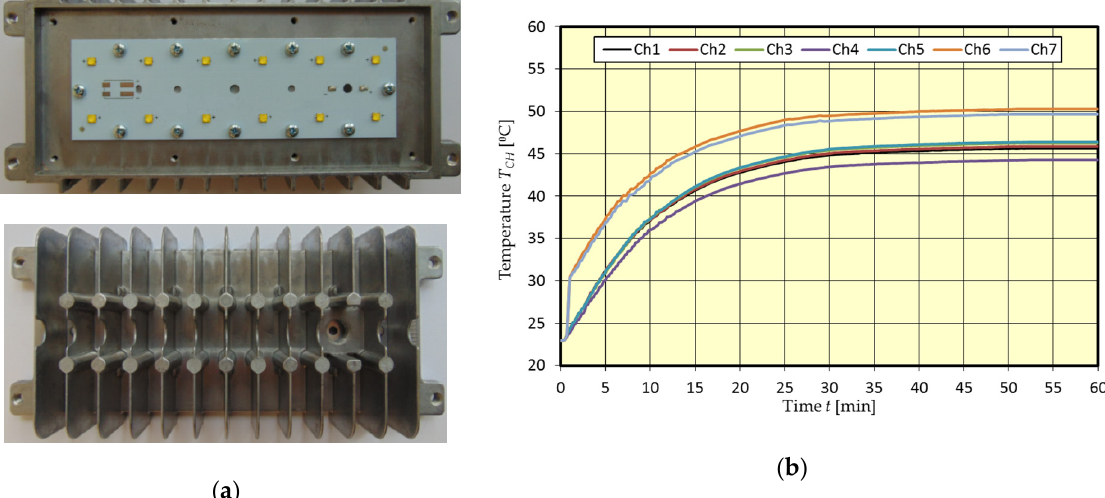
Figure 10. View of the LED panel prototype ( a ) and temperature curves of seven measuring channels for forward current I F = 700 mA ( b ).